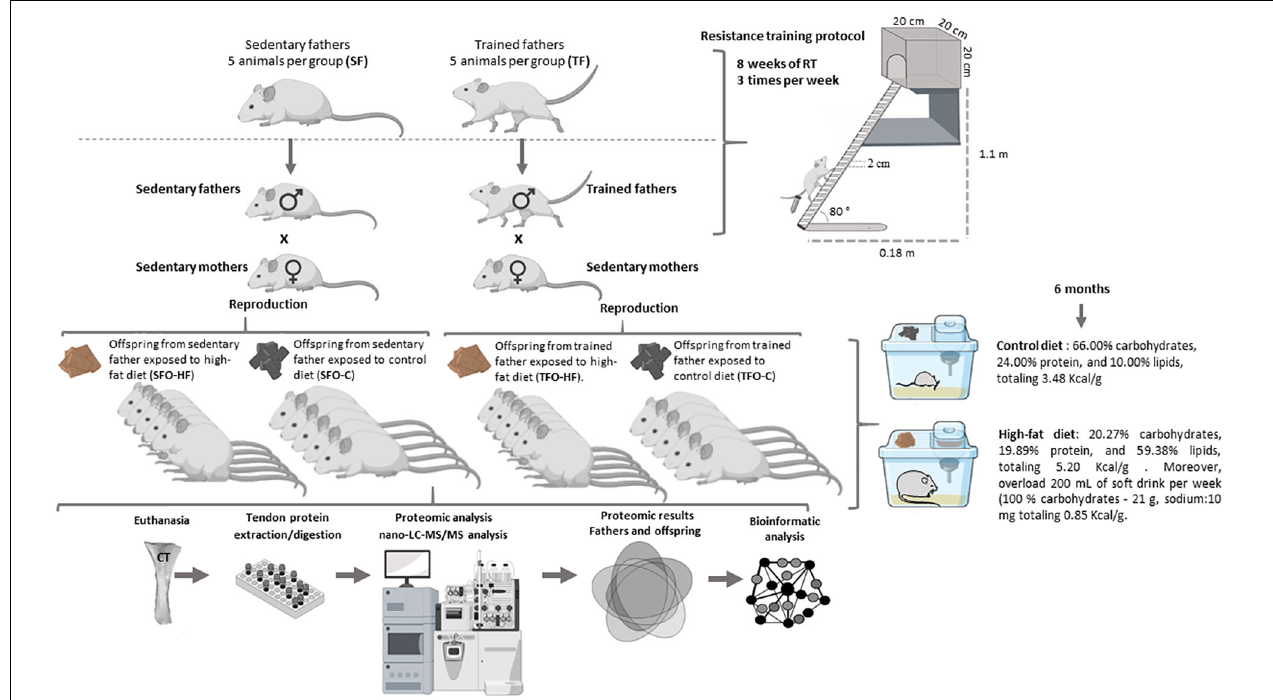
FIGURE 1 | Experimental design. Schematic representation of the methodological sequence followed in the